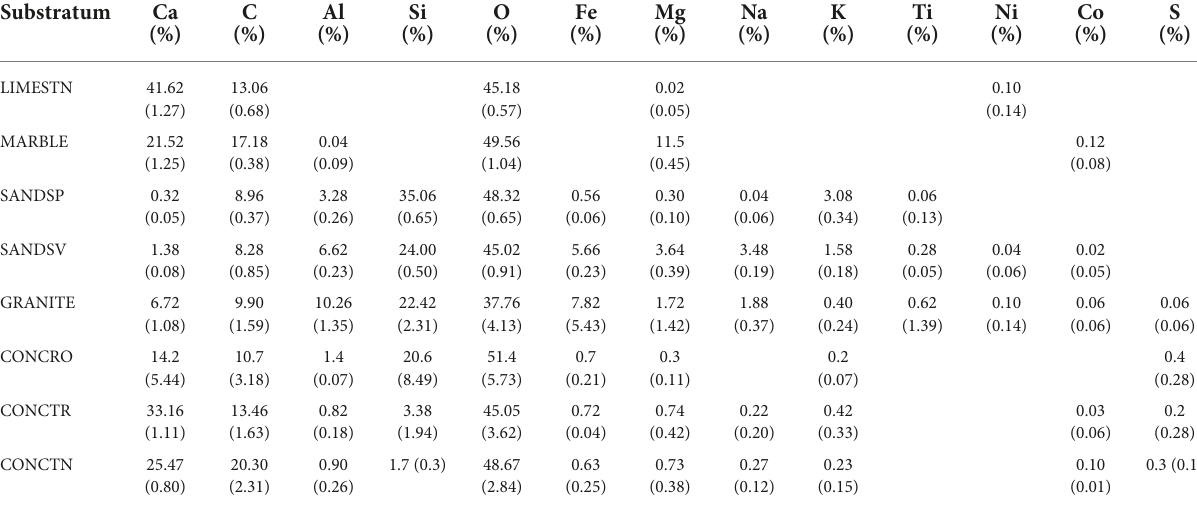
TABLE 1 Surface elemental composition of the treatment stone types obtained from